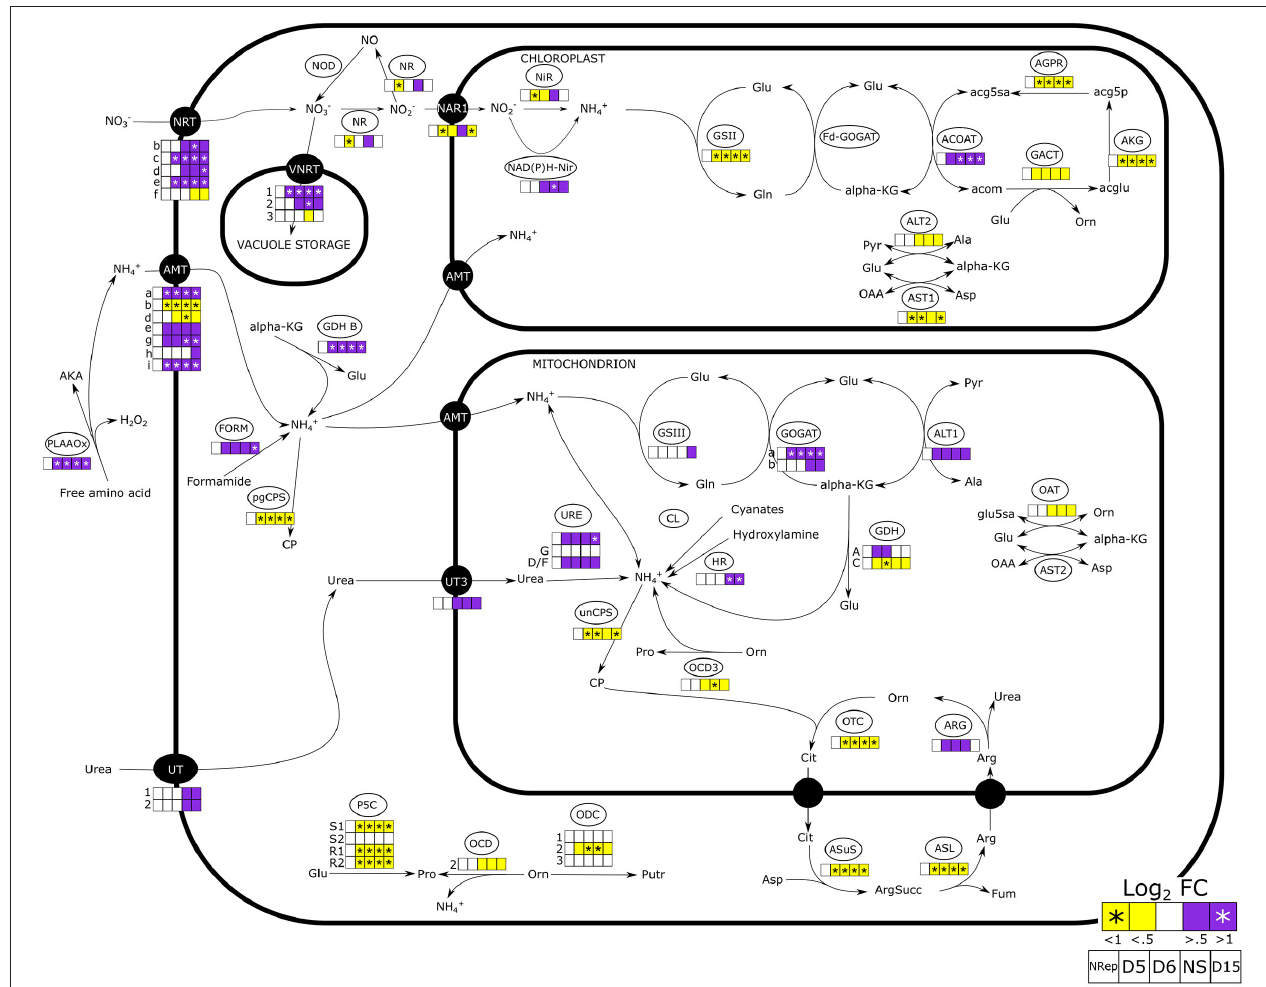
FIGURE 4 | Nitrogen uptake and assimilation pathways in Phaeodactylum tricornutum . The heatmaps report the change in gene expression in the 5 different groups defined through the PCA analyses (Nrep, D5, D6, NS, and D15). Daily variations of gene expression are reported in Supplementary Figure 7 . NRT, nitrate transporter; VNRT, vacuolar nitrate transporter; NR, nitrate reductase; NAR1, nitrite transporter; Nir, nitrite reductase; NAD(P)H-Nir, nitrite reductase NAD(P)H dependent; GSII/III, glutamate-ammonia ligase; GOGAT, glutamate synthase; ACOAT, acetylornithine aminotransferase; AGPR, N-acetyl-gamma-glutamyl-phosphate reductase; GACT, glutamate N-acetyltransferase; AKG, acetylglutamate kinase; ALT, L-alanine transaminase; AST, aspartate aminotransferase; PLAAOx, periplasmic L-amino acid oxidase; FORM, formamidase; GDH, glutamate dehydrogenase; CP, carbamoyl phosphate; pgCPS, carbamoyl phosphate synthetase; unCPS, carbamoyl phosphate synthase mitochondrial, UT, urea transporter; URE, urease; CL, cyanate lyase, HR, Hydroxylamine reductase; GDH, glutamate dehydrogenase; OCD, ornithine cyclodeaminase; ODC, ornithine decarboxylase; P5CS, pyrroline-5-carboxylate synthase; P5CR, pyrroline-5-carboxylate reductase; OTC, ornithine transcarbamylase; ARG, arginase; ASL, argininosuccinate lyase; ASuS, argininosuccinate hydratase; AKA, α -keto